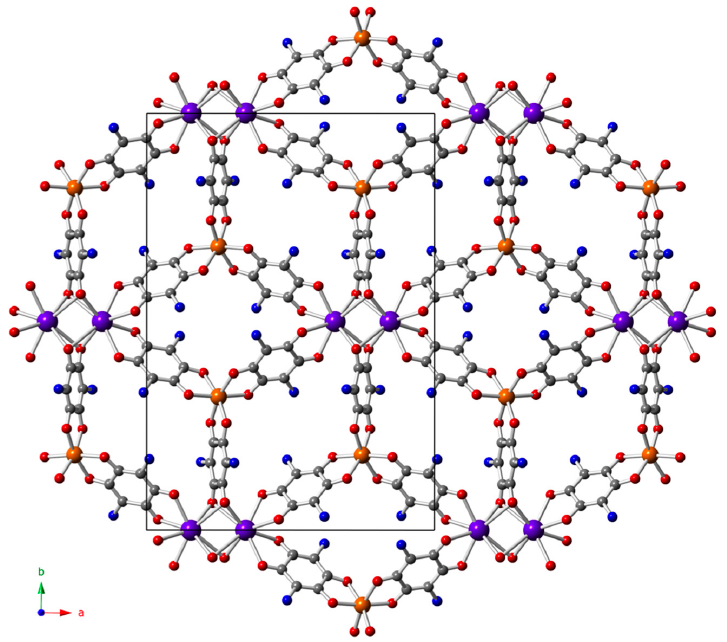
Figure 3. View of the 3,6-connected anionic layer [NaFe(C 6 N 2 O 8 ) 3 ] 2 − generated with Fe(III) and pairs of Na + cations (the oxygen atoms of the NO 2 groups have been omitted for clarity). Color code: Fe = orange, Na = purple, O = red, N = blue and C = grey.